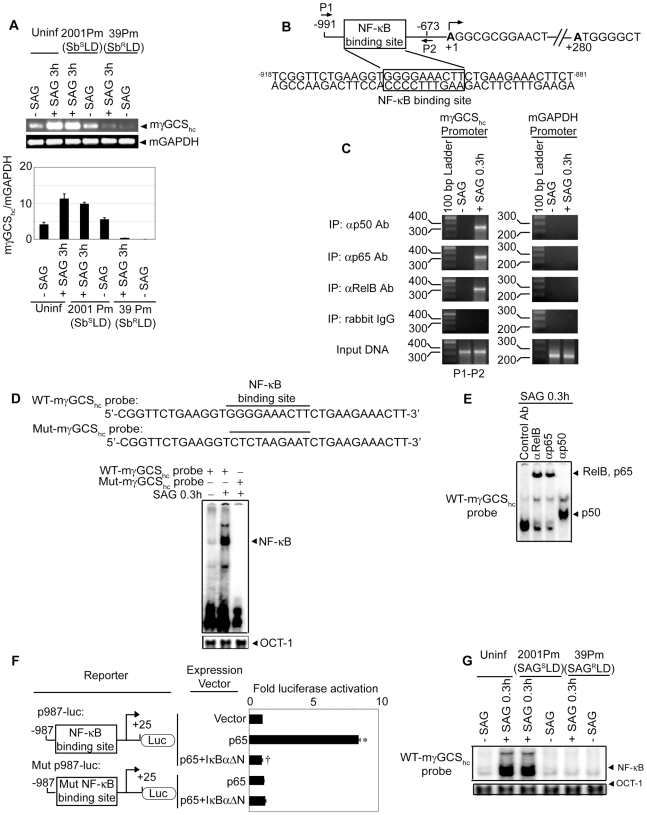
Suppression of SAG-induced mγGCShc expression by SbRLD is NF-κB-dependent.Both uninfected BMDCs (A, C-E, G) and BMDCs infected with 2001Pm (SbSLD) or 39Pm (SbRLD) for 3 hours (A, G) were stimulated with SAG (20 µg/ml) for specified times as in Figure 4. (A) The mRNA expression of mγGCShc versus mGAPDH was determined via RT-PCR. Densitometric data represent ratio of intensity of mγGCShc to mGAPDH mRNA expression per unit area and are presented as an arbitrary unit. (B) Schematic presentation of mγGCShc promoter indicating the position of NF-κB binding site and ChIP primers (P1, P2). (C) NF-κB binding to −991/−673 region of mγGCShc promoter was examined by ChIP using the primers shown in B and indicated Abs. Amplification of mGAPDH promoter and chromatin immunoprecipitated by rabbit IgG were used as negative controls, and input DNA (2%) as an internal control. (D, G) Nuclear NF-κB DNA binding to mγGCShc promoter-specific probes containing wild-type NF-κB binding site (WT-mγGCShc probe) (D, G) or mutant NF-κB binding site (Mut-mγGCShc probe) (D) was determined via EMSA. OCT-1 DNA binding activity was used as internal control. (E) DNA binding of different NF-κB complexes to WT-mγGCShc probe was determined via supershift analysis using rabbit IgG (Control Ab) or Abs specific for indicated NF-κB subunits. (F) NF-κB-mediated regulation of mγGCShc promoter activity was determined by reporter assay. NIH3T3 cells were co-transfected with Renilla luciferase vector (pRL-CMV) and firefly luciferase reporter plasmid containing mγGCShc promoter with wild-type (p987-luc) or mutant (Mut p987-luc) NF-κB binding site. In addition, all co-transfections contained pEGFP-C1 empty vector or pEGFP-p65 and/or pEGFP-IκBαΔN. Twenty-four hours later, firefly and Renilla luciferase activities in cell lysates were measured. The data represent the fold induction of firefly/Renilla luciferase activity ratio relative to pEGFP-C1-transfected cells. Data are representative of three independent experiments. *p<0.001 versus NIH3T3+p987-luc+pEGFP-C1 and †p<0.001 versus NIH3T3+p987-luc+pEGFP-p65 (Student's t test). Error bars indicate mean ± SD.